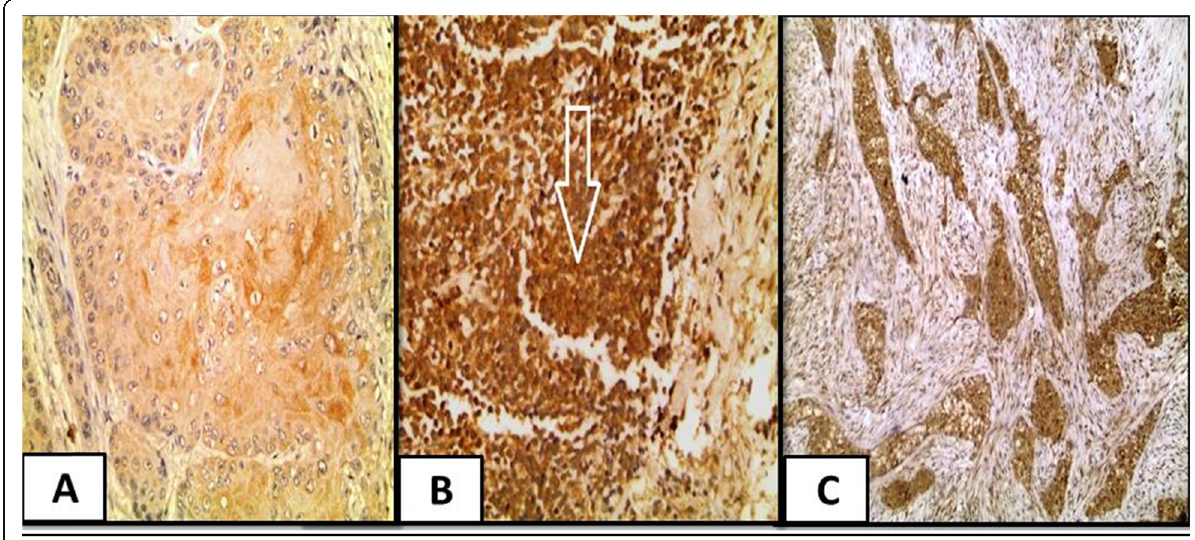
Fig. 3 CAIX expression in studied cases. a A case of moderately differentiated squamous cell carcinoma showed positive moderate cytoplasmic expression of CAIX (IHC × 400). b A case of small cell neuroendocrine carcinoma showed positive strong cytoplasmic expression of CAIX (IHC × 400). c A case of invasive urothelial carcinoma, high grade with positive strong cytoplasmic expression of CAIX and positive desmoplastic stromal reaction (IHC X